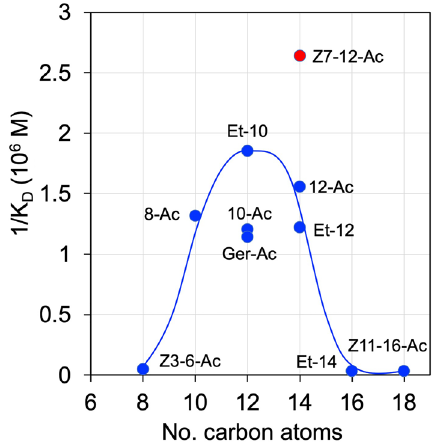
Figure 6. Affinities of some esters to LafrOBP1 plotted as a function of the number of carbon atoms. The pheromone ( Z )-7-dodecenyl acetate was the strongest ligand, while some other esters of 10–14 carbon atoms also bound with lower affinities. Homologous esters of less than 10 or more than 14 carbon atoms did not show significant binding for LafrOBP1. Z3-6-Ac: ( Z )-3-hexenyl acetate; 8-Ac: 1-octyl acetate; 10-Ac: 1-decyl acetate; Ger-Ac: geranyl acetate; Et-10: ethyl decanoate; Z7-12-Ac: ( Z )-7-dodecenyl acetate; 12-Ac: 1-dodecyl acetate; Et-12: ethyl dodecanoate; Et-14: ethyl tetradecanoate; Z11-16-Ac: ( Z )-11-hexadecenyl